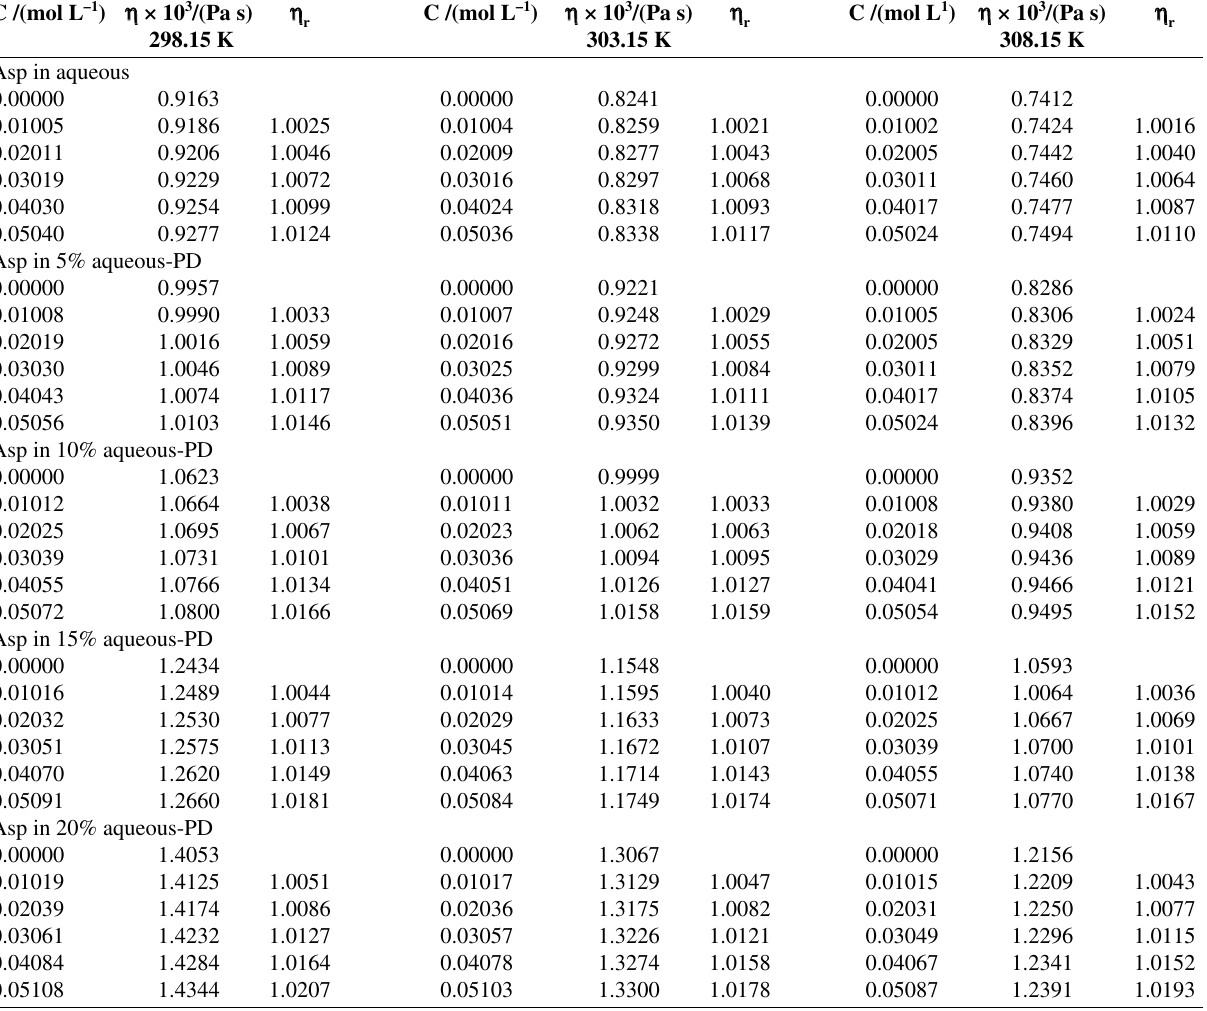
Table 7. Viscosities, η , and relative viscosities, η ity, C, of Asp at different temperatures. C /(mol L –1 ) ηη × 10 3 /(Pa